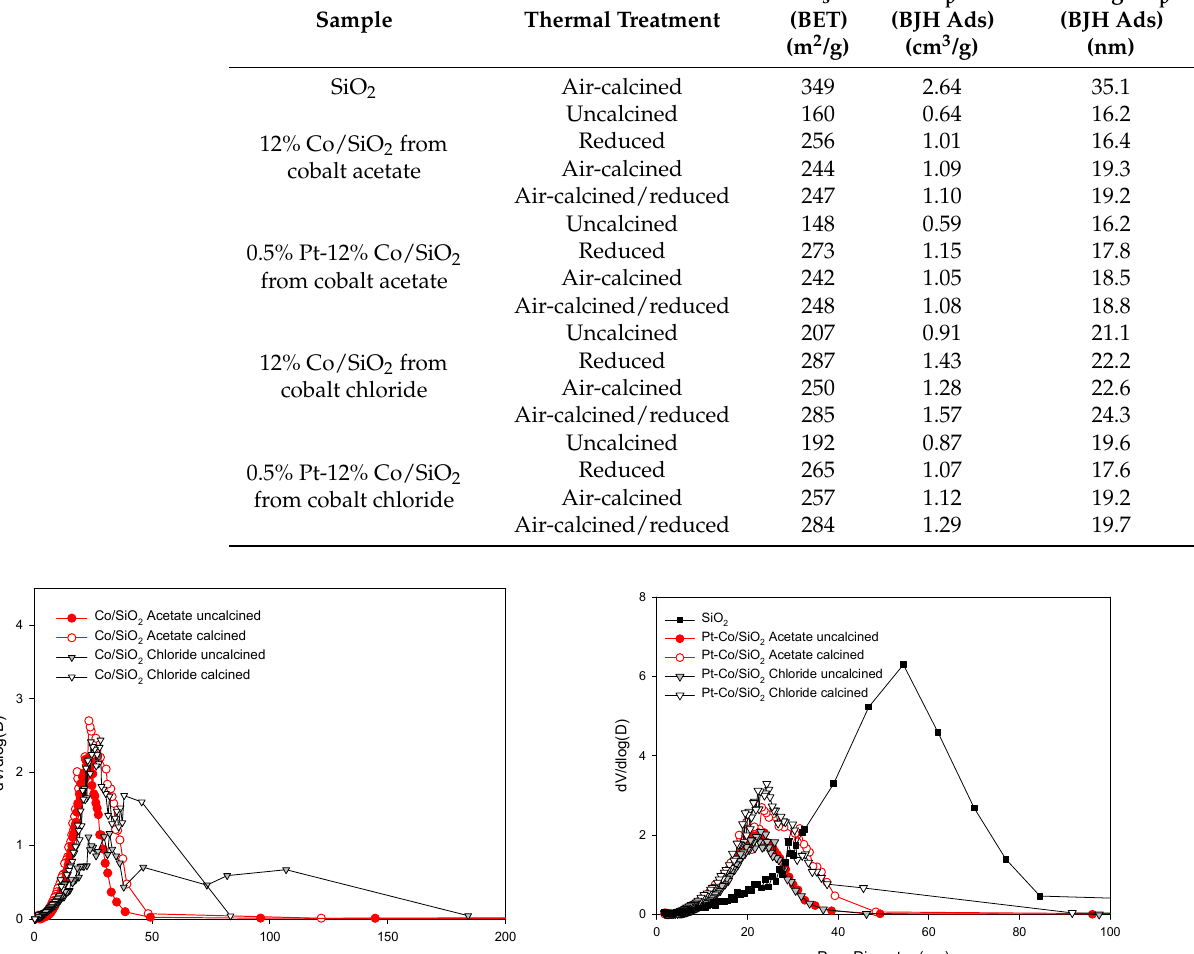
Figure 1. Pore size distribution (PSD, adsorption branch) for unpromoted and Pt-promoted Co/SiO 2 prepared from cobalt acetate and cobalt chloride, including by direct H 2 reduction versus air calcination/H 2 reduction. Table 1. BET surface area and BJH porosity measurement (N 2 adsorption branch).